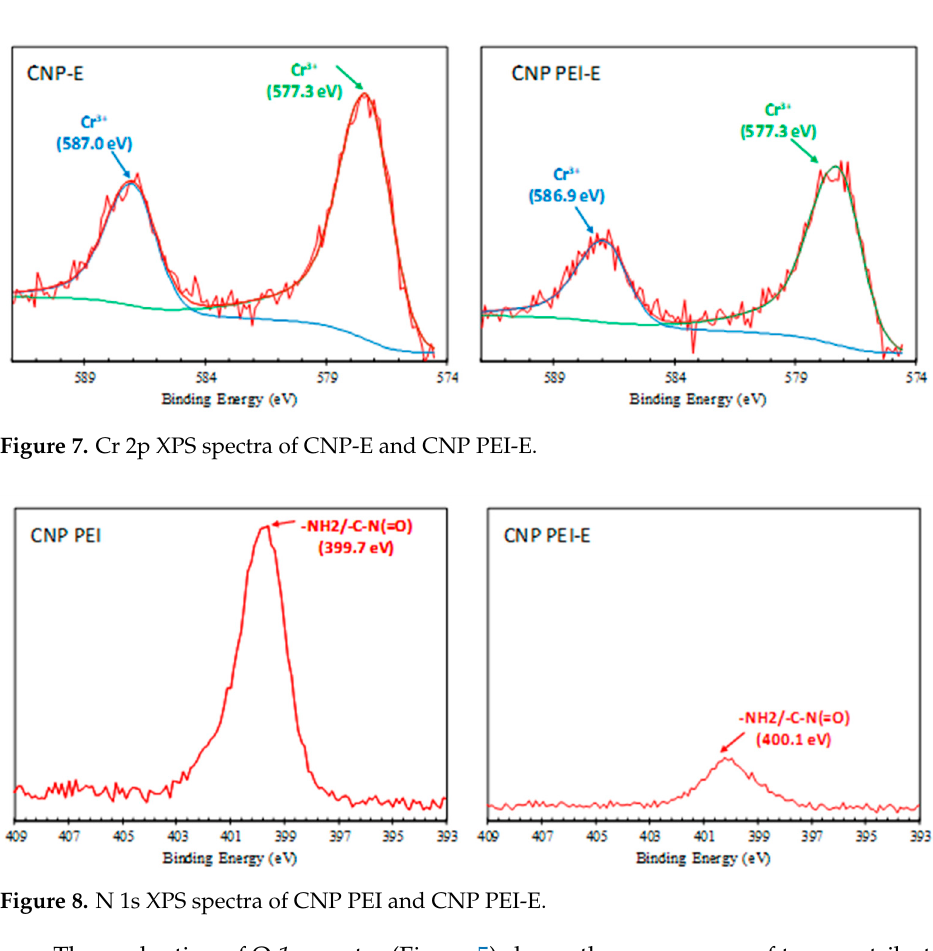
Figure 6. P 2p XPS spectra of CNP, CNP-E, CNP PEI, CNP PEI-E.